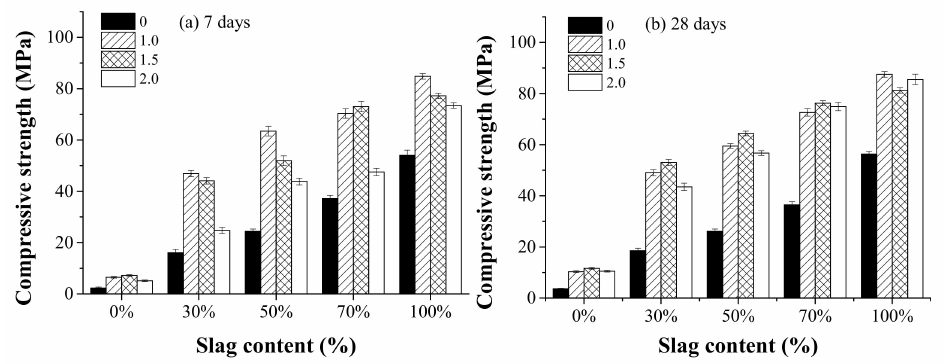
Figure 8. The e ff ect of the activator modulus (0, 1.0, 1.5, 2.0) and the slag content (0%, 30%, 50%, 70% and 100%) on compressive strength at the curing age of 7 days ( a ) and 28 days ( b